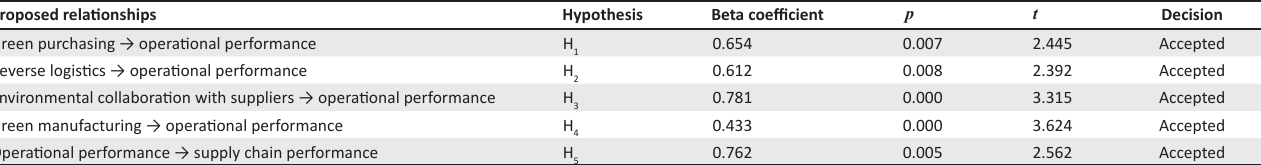
TABLE 4: Hypotheses tests results. Proposed